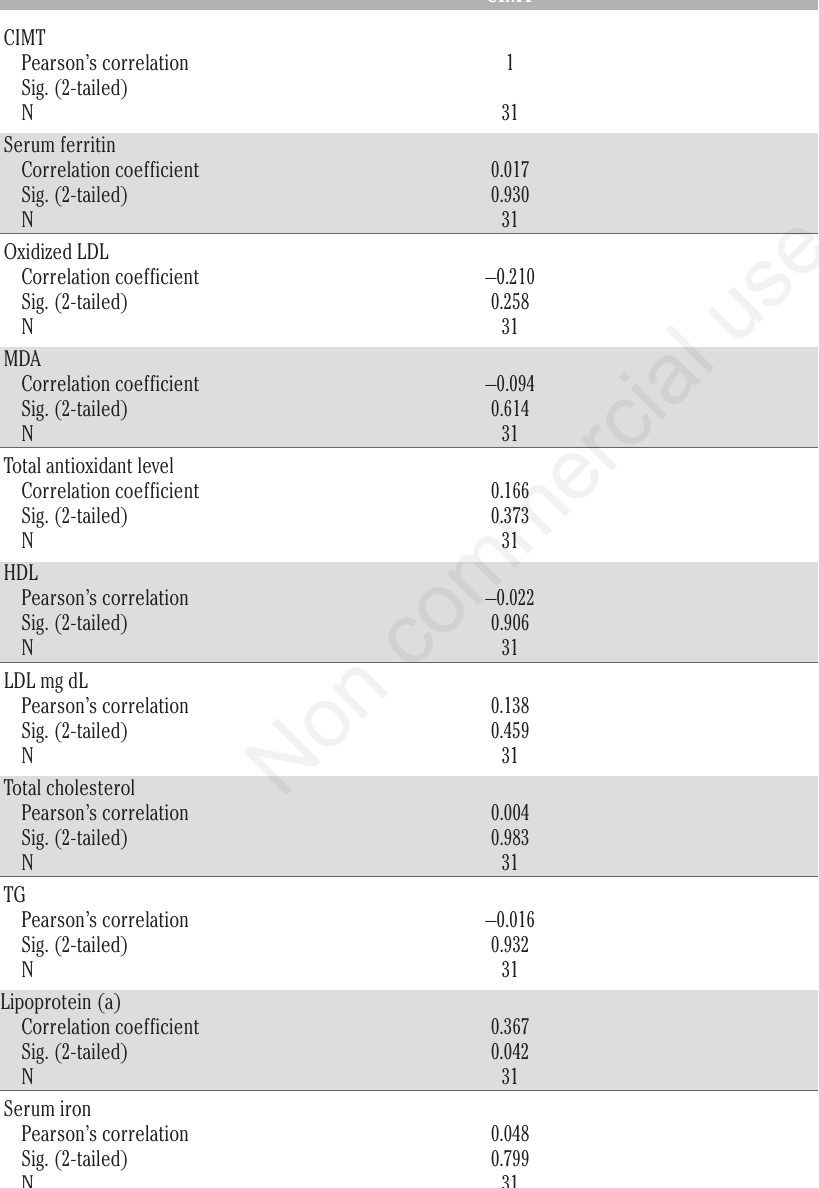
Table 5. Correlation of carotid intima-media thickness with secondary outcome variables in